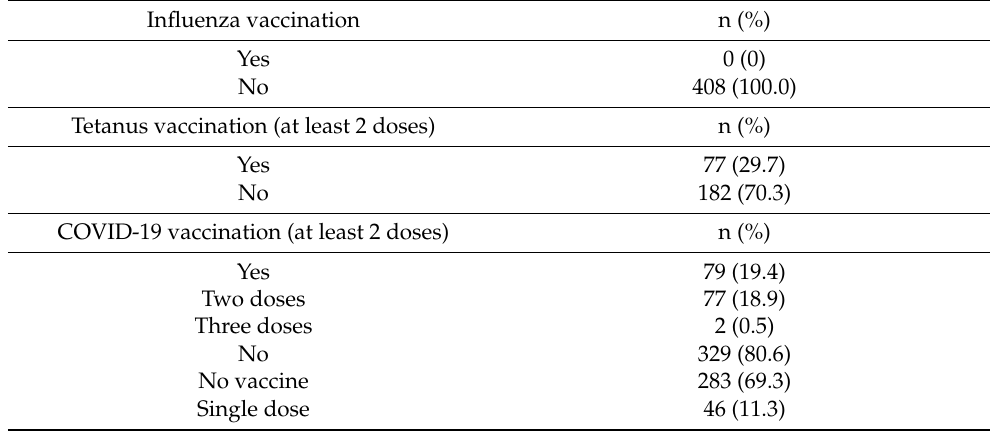
Table 2. Vaccine uptake and frequency of COVID-19 infection of pregnant women.